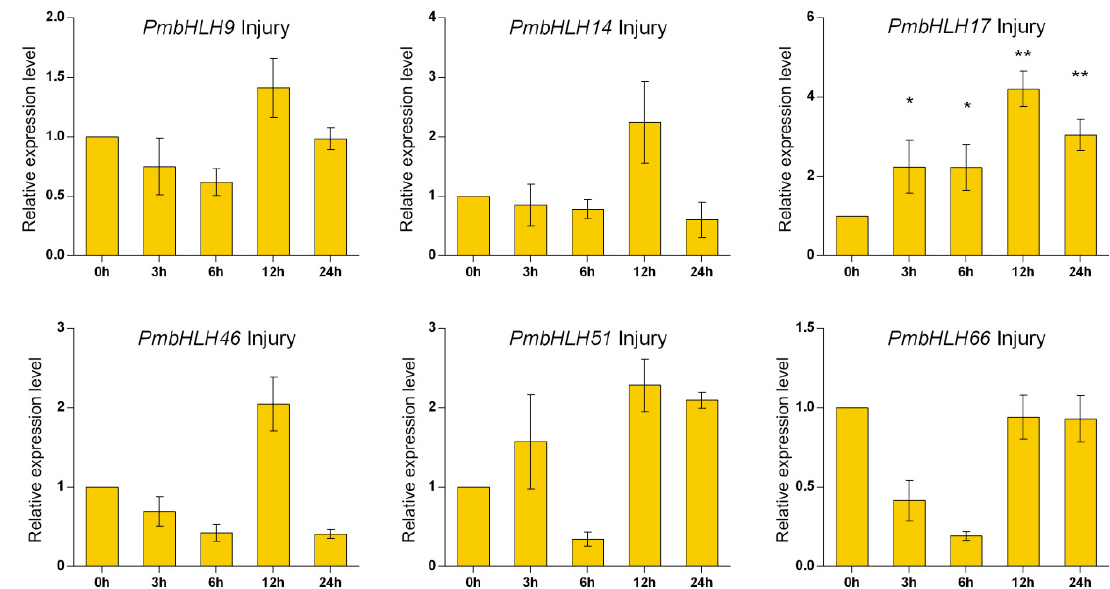
Figure 5. Expression of six PmbHLH genes under six treatments. Asterisks represent significant differences between each time point and 0 h (* p < 0.05, ** p < 0.01).